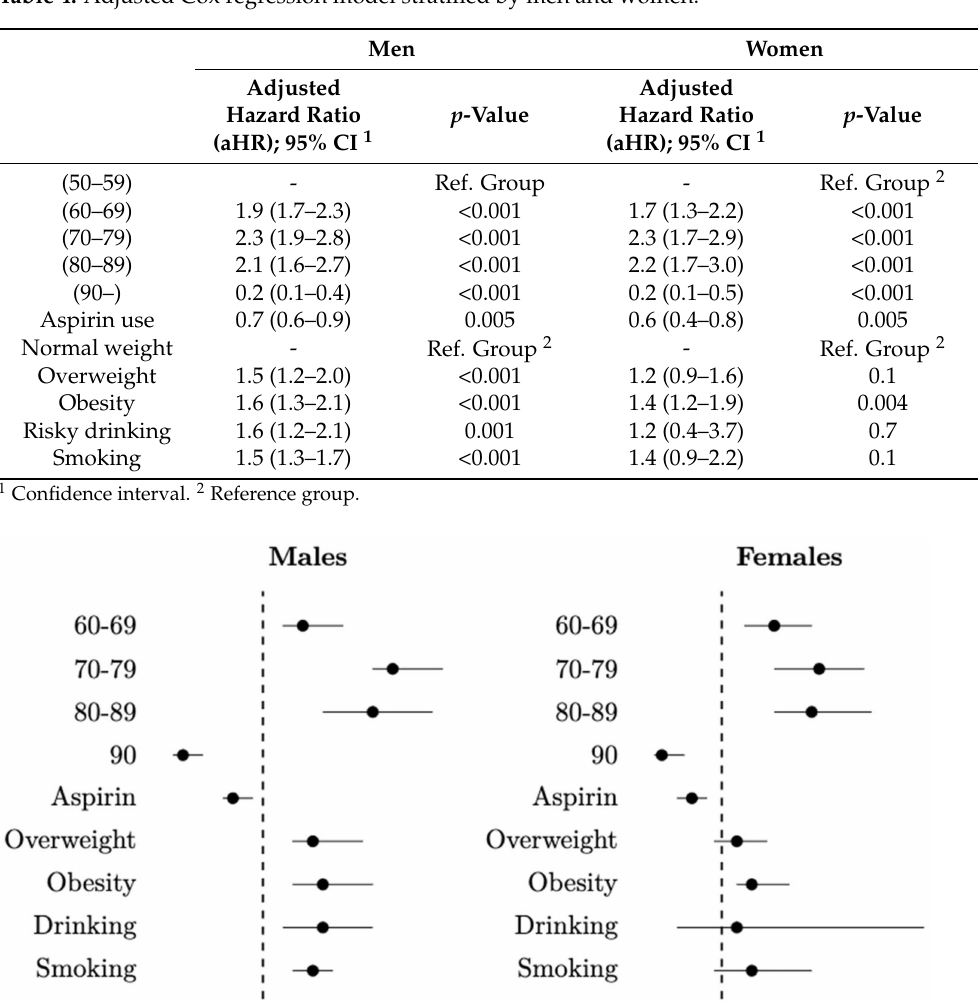
Figure 3. Hazard ratios by Cox regression adjusted for gender, age, aspirin use, BMI, risky drinking and tobacco smoking. Table 4. Adjusted Cox regression model stratified by men and women.